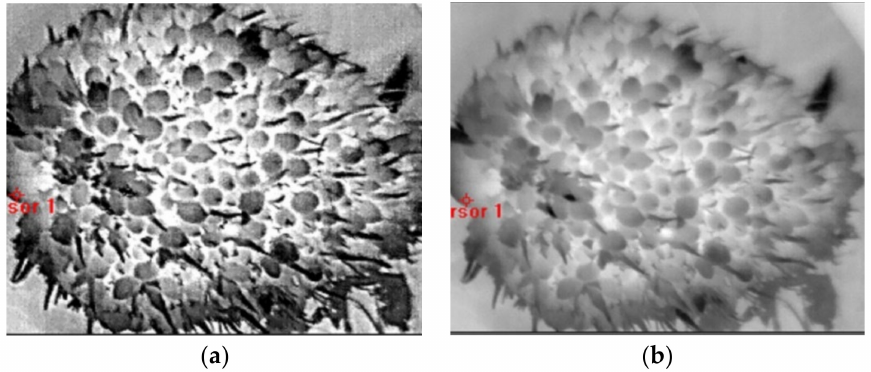
Figure 4. The FFB Image: ( a ) before and ( b ) after the noise is removed.